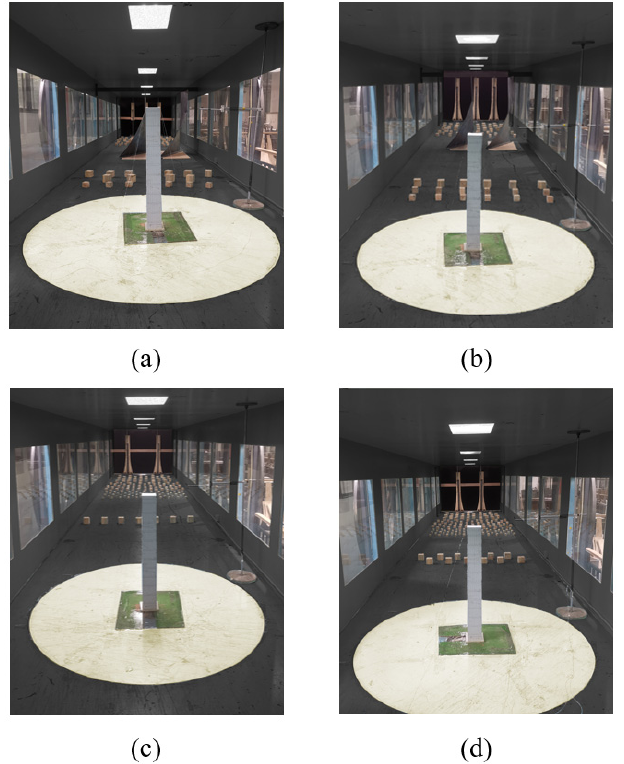
Figure 4. Photos of wind tunnel tests in the cases of ( a ) TWF30-0°; ( b ) TWF20-0°; ( c ) CWF1-0°; and ( d ) CWF2-0°.